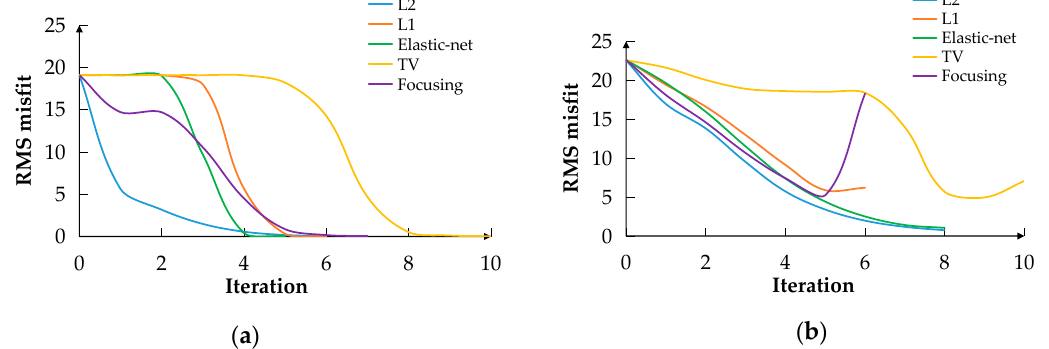
Figure 3. RMS misfit evolution of the MT separate inversion ( a ) and gravity separate inversion ( b